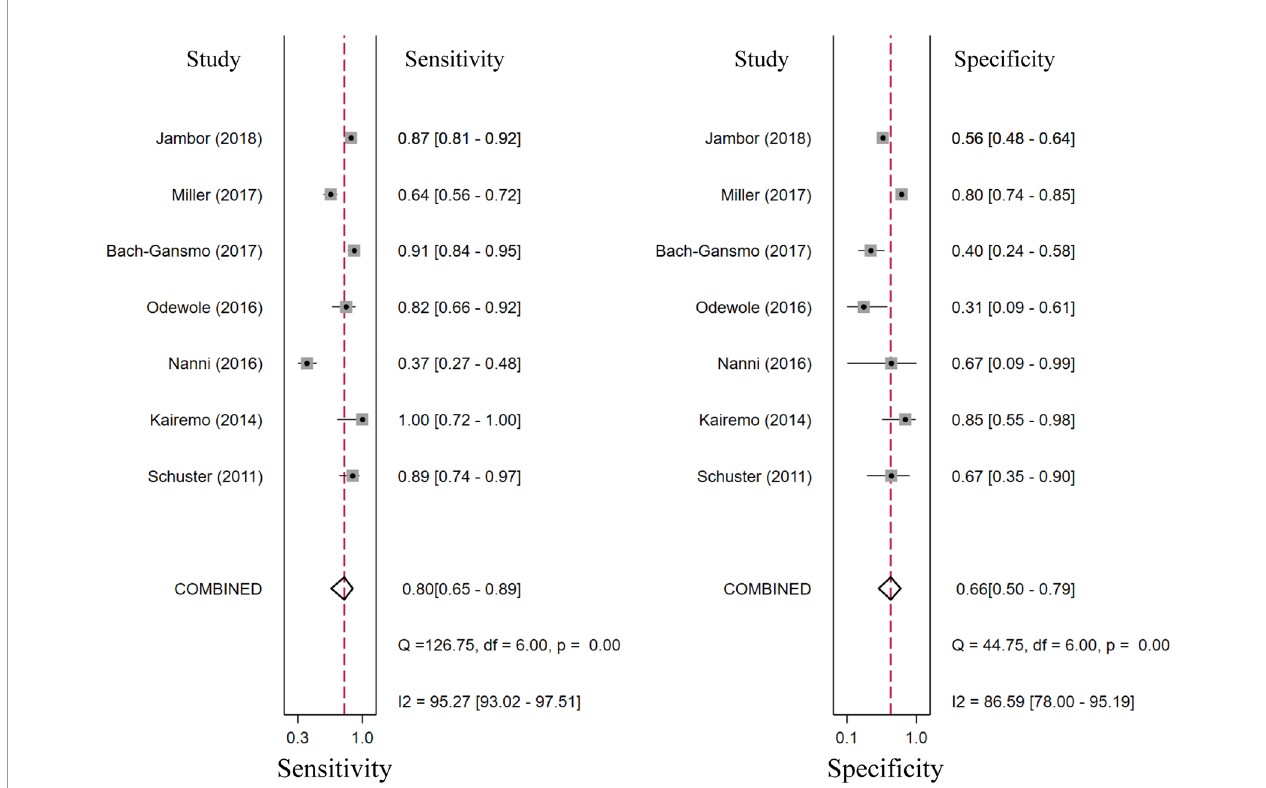
FIGURE 4 | Forest plot of the proportion of 18 F- fl uciclovine PETCT sensitivity and speci fi city in prostate cancer patients with biochemical recurrence.